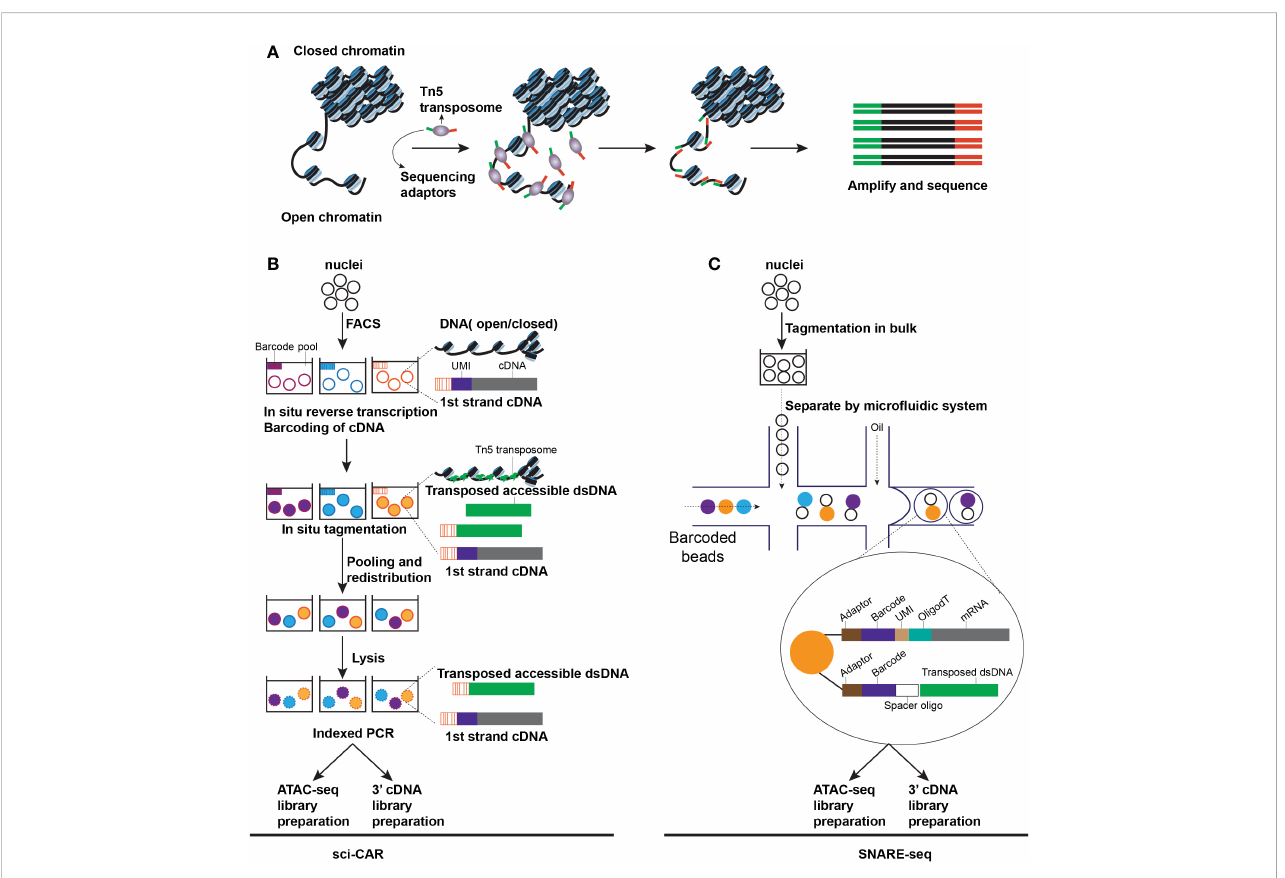
FIGURE 2 Techniques for capturing chromatin accessibility from an individual cell. (A) The schematic of ATAC-seq. Open chromatin regions can be inserted by transposome and generate fragments that can be ampli fi ed by PCR (B) The schematic of sci-CAR seq. All nuclei are extracted and distributed by Fluorescence-activated Cell Sorting (FACS) to each pool. A fi rst cDNA sequence can be introduced by reverse transcription with a pool-speci fi c Barcode and a unique molecular identi fi er (UMI). After barcoding cDNA, a fi rst transposed dsDNA sequence is introduced by Tn5 transposase in situ tagmentation assay, bearing a pool-speci fi c barcode. Then redistributed nuclei, each of them is lysed, and the lysate is split into two parts, one half prepares for the library of 3 ’ cDNA, another half prepares for the library of ATAC-seq (C) . The schematic of SNARE-seq. A micro fl uidic system has been applied in SNARE- seq and enabled parallel capture of transcriptome and chromatin accessibility from a single